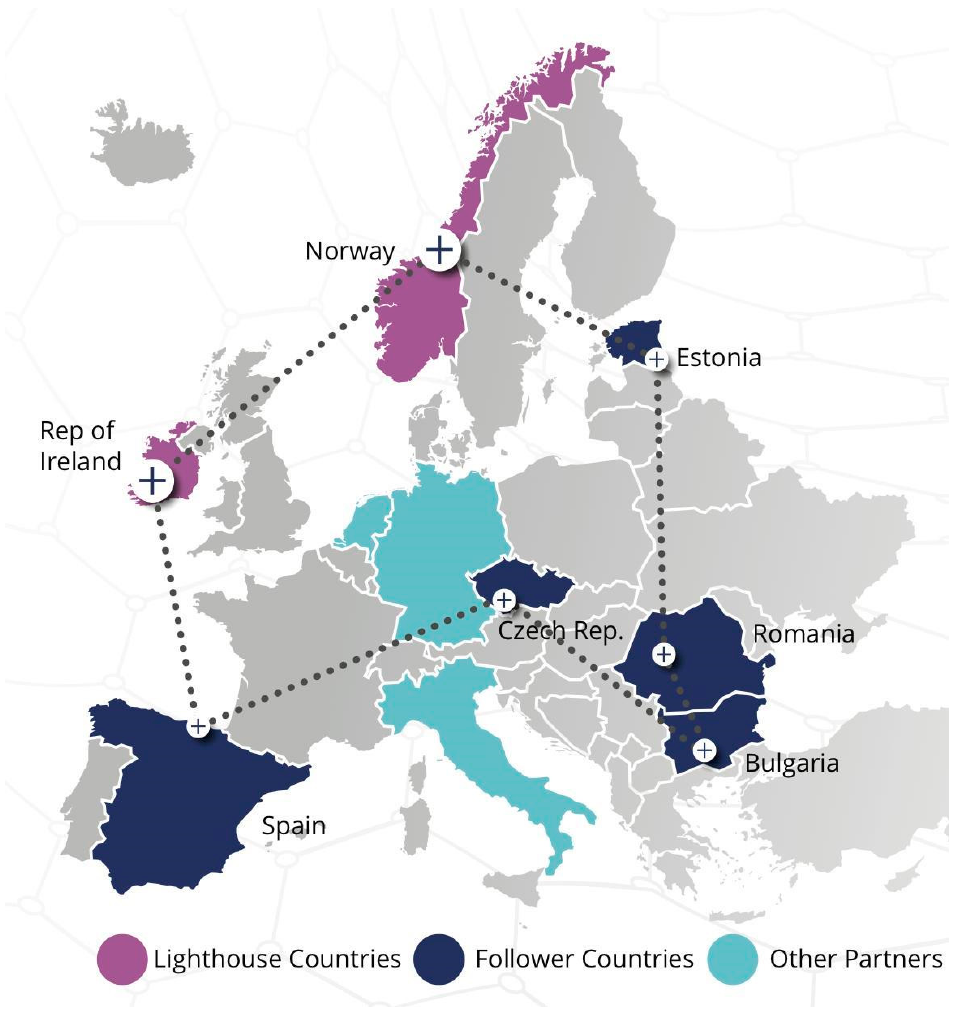
Figure 1. All +CityxChange project Cities Map (Source: [23] )